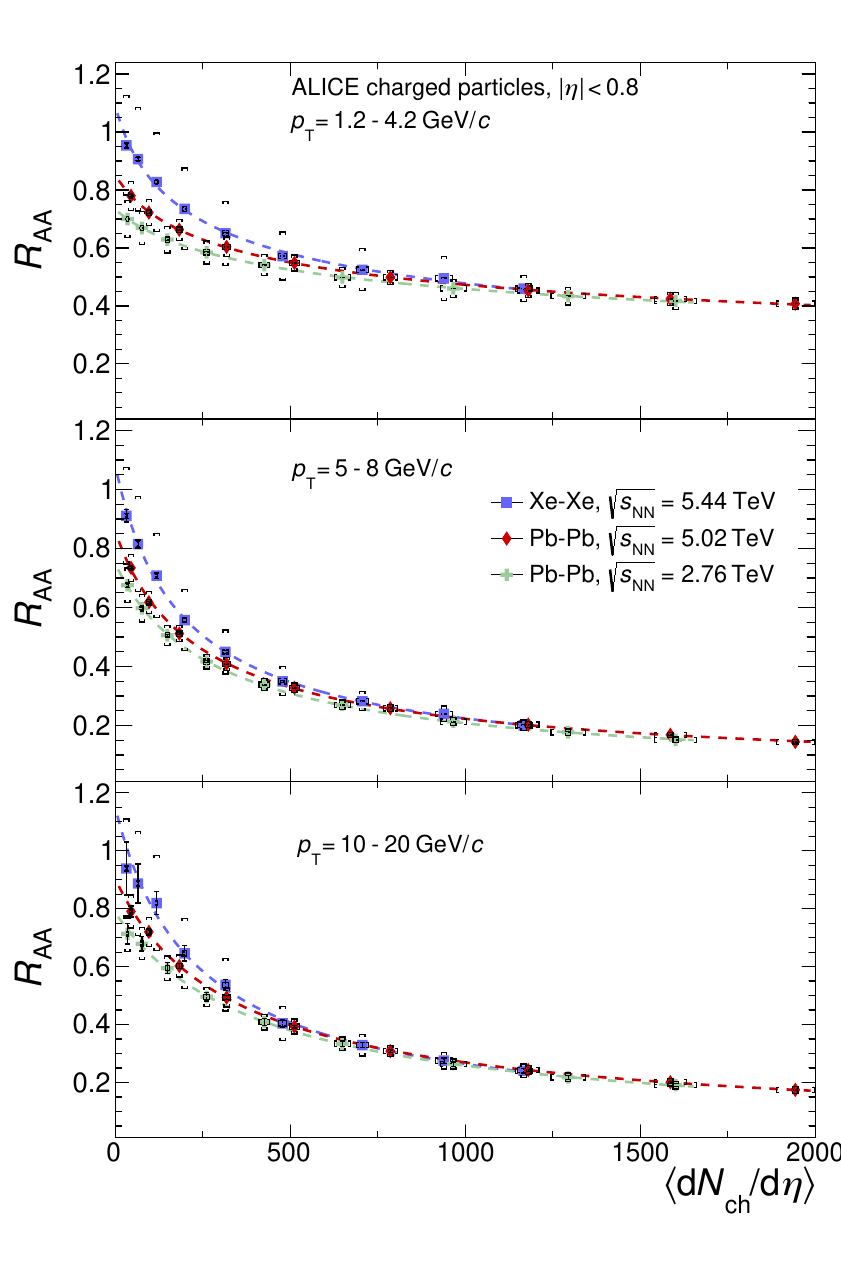
Figure 2. Comparison of the nuclear modification factor in Xe–Xe and Pb–Pb collisions integrated over identical regions in p T as a function of < dN ch / d η >